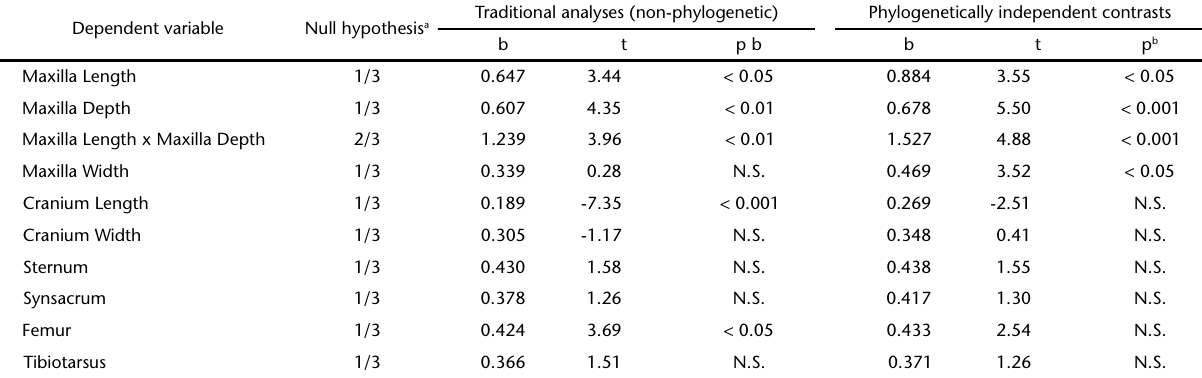
Table III. Allometric exponents (b) of regression of skeletal measures on body mass of 21 species of Ramphastidae in traditional analyses and in phylogenetically independent contrasts. Dependent variable